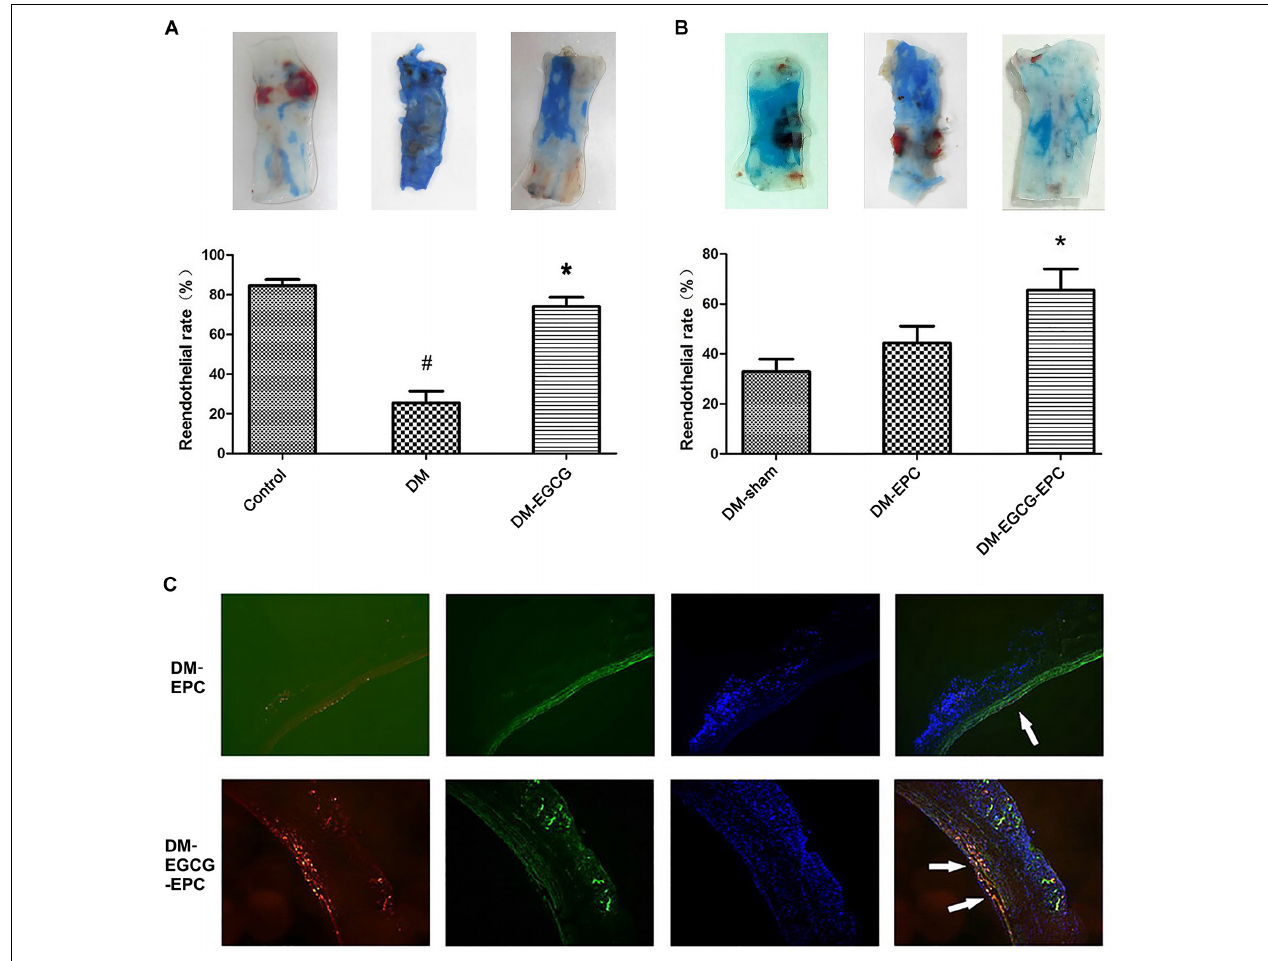
FIGURE 3 | Reendothelialization of injured carotid arteries is promoted by EGCG. (A) Reendothelialization of injured carotid arteries is promoted by intragastrically-given of EGCG. The blue area, which was rendered by Evans Blue, represent the area of carotid artery where lack of endothelium. The control group shows the best reendothelialization, whereas diabetes rabbits show very poor reendothelialization. After intragastrically given EGCG for 7 days, the reendothelialization rates risen. The number of rabbits in each group was 6. DM: diabetic rabbits were given with saline intragastrically after injured carotid artery operation. DM-EGCG: diabetic rabbits were given with EGCG 50 mg/kg/day intragastrically for 7 days after injured carotid artery operation. # P < 0.05 and ∗ P < 0.05 compared to the control group or the diabetes group, respectively. (B) EGCG pre-treated autologous L-EPCs transfusion improved diabetic rabbits carotid reendothelialization. The panel shows the representative reendothelialization photographs of the 3 groups ( n = 6 for each group). After autologous L-EPCs transplantation, diabetic rabbits’ carotid reendothelialization was improved but no statistical difference; however, by transfusion autologous EGCG pre-treated L-EPCs, the reendothelialization was significantly improved. DM-sham: injured carotid artery of diabetic rabbits were washed and then incubated 10 min by saline after injured operation. DM-EPC: autologous L-EPCs were transplanted into the area of injured carotid artery of diabetic rabbits after injured carotid artery operation. DM-EGCG-EPC: EGCG pre-treated autologous L-EPCs were transplanted into the area of injured carotid artery of diabetic rabbits after injured carotid artery operation. ∗ P < 0.05 compared to the diabetic sham group. (C) Representative figure of autologous L-EPC tracking in vivo under fluorescent microscope. Picture shows the extent to which L-EPCs are involved in reendothelialization 7 days after carotid artery injury. CM-DiI-labeled L-EPCs (red) are attached to endothelium (FITC-lectin-stained, green). Nuclei of L-EPC were stained with DAPI (blue).